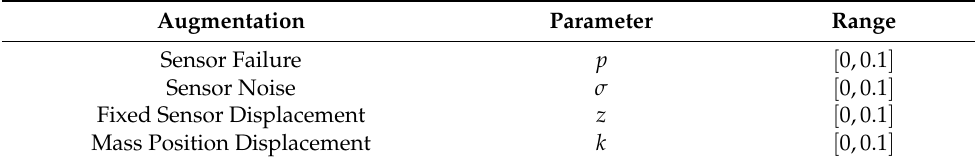
Table 1. The parameter ranges used for each type of simulated error. Augmentation